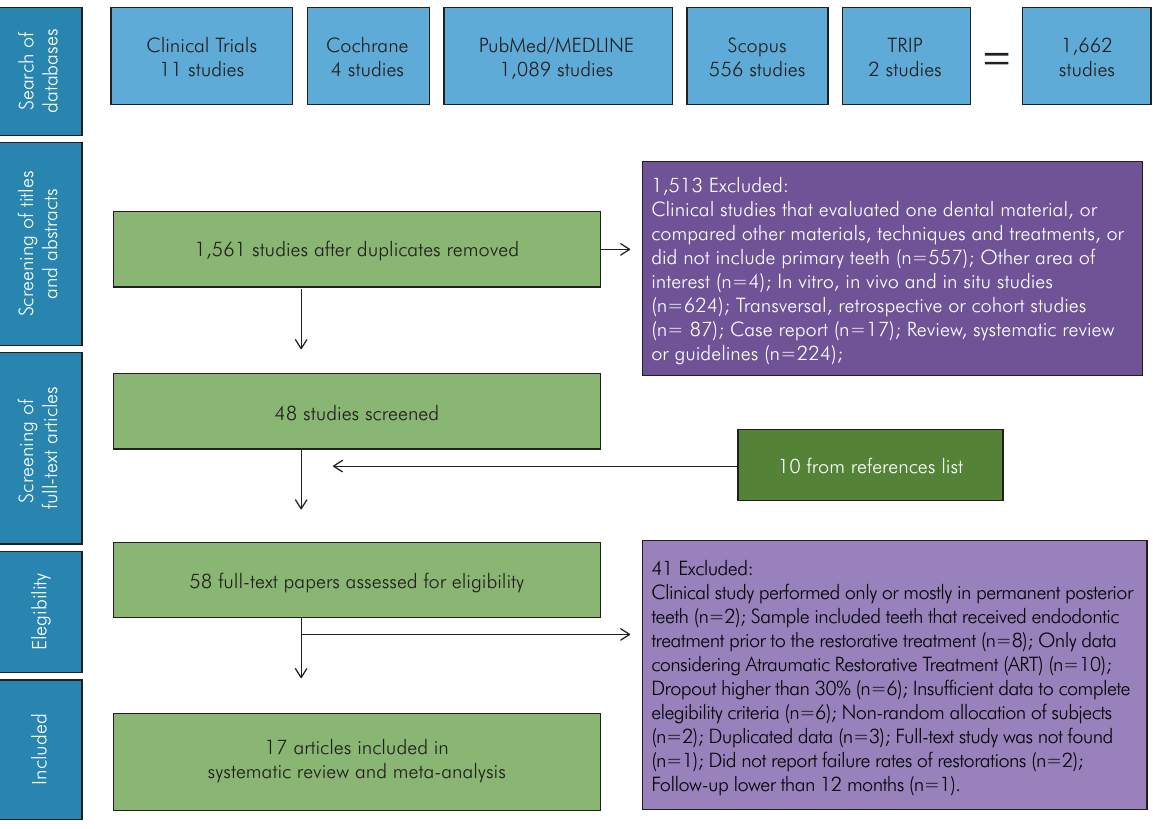
Figure 1. PRISMA flow diagram outlining the study selection